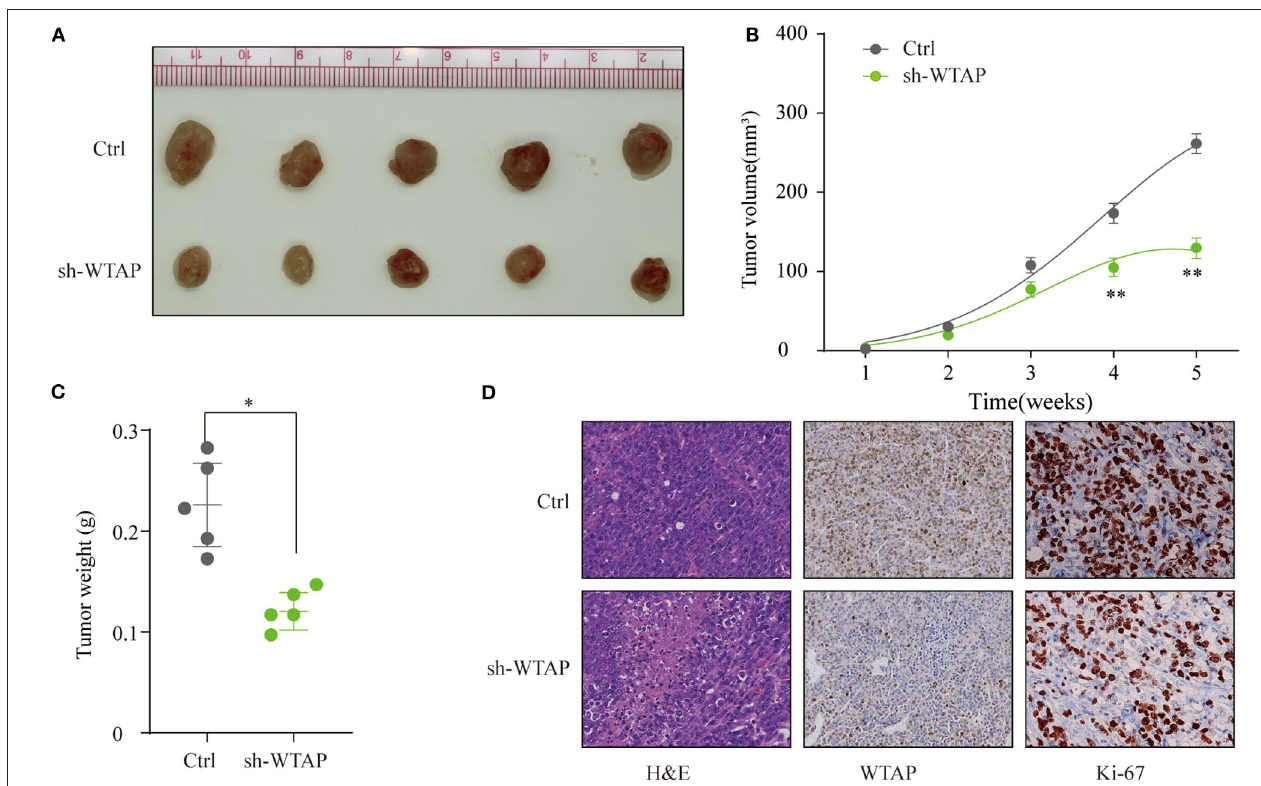
FIGURE 4 | Knockdown of WTAP suppresses the HCC tumorigenesis in vivo SMMC-7721 cells stably transfected with a sh-WTAP or negative control (NC) were subcutaneously implanted into nude mice, and the tumor growth was monitored. (A) Representative photos of nude mice and HCC tumor tissues from the control (Ctrl) or sh-WTAP group at week 5. (B) Tumor volume was monitored and calculated at the indicated time points. (C) Tumor weight of tumors from the Ctrl or sh-WTAP group were analyzed; n = 5 per group. (D) Representative IHC staining and the expression levels of WTAP or Ki-67 in the tumor tissues from the Ctrl or sh-WTAP group. * p < 0.05, ** p <